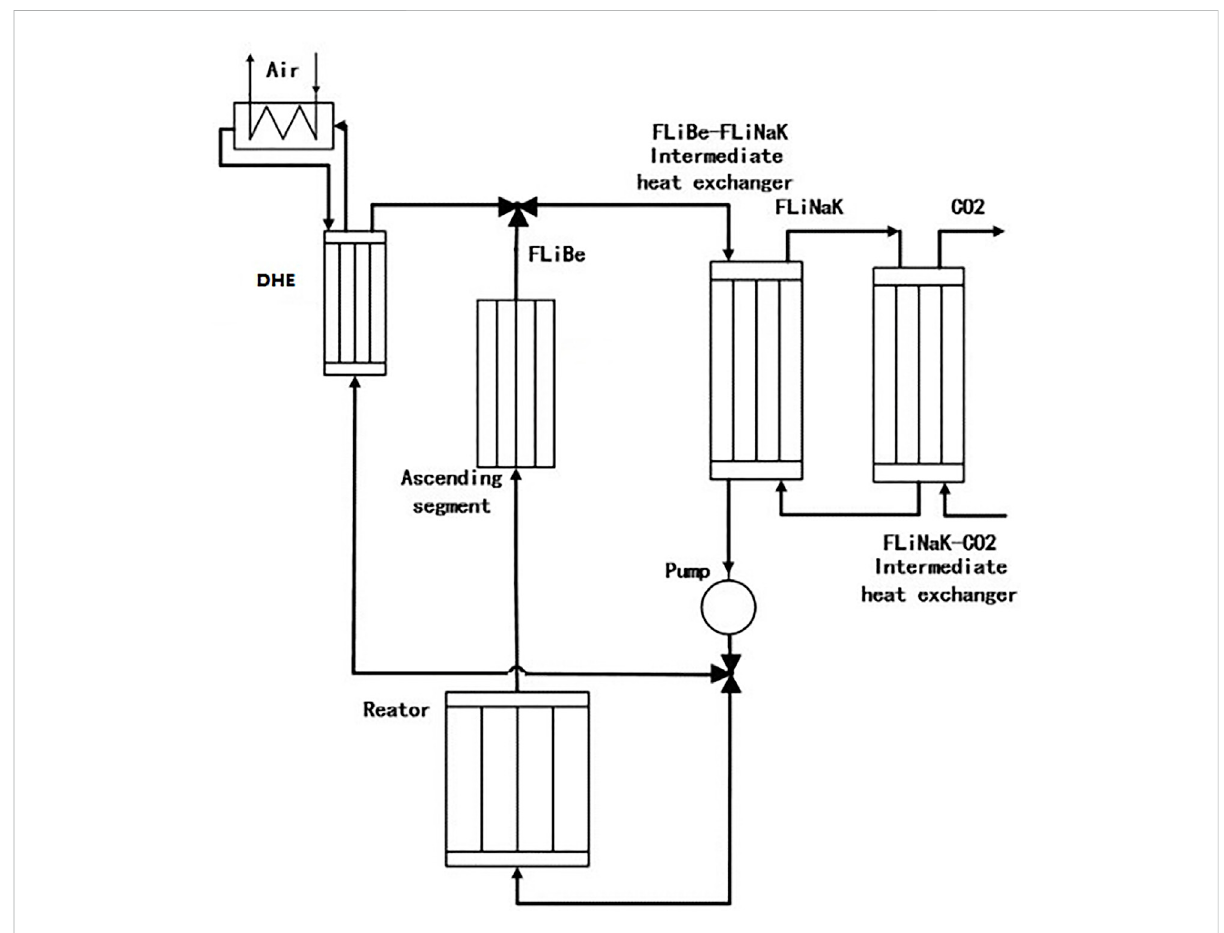
FIGURE 1 Diagram of the primary loop of the FHR.